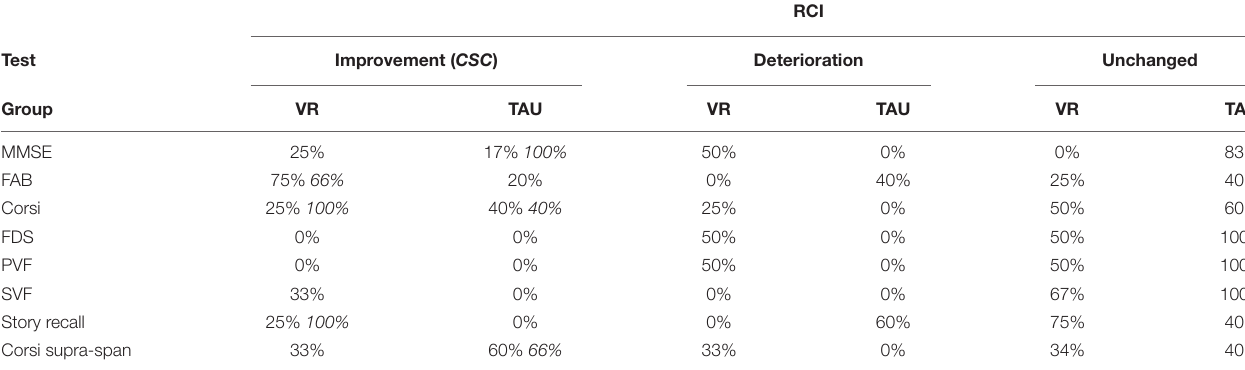
TABLE 5 | Results of VR and TAU training.